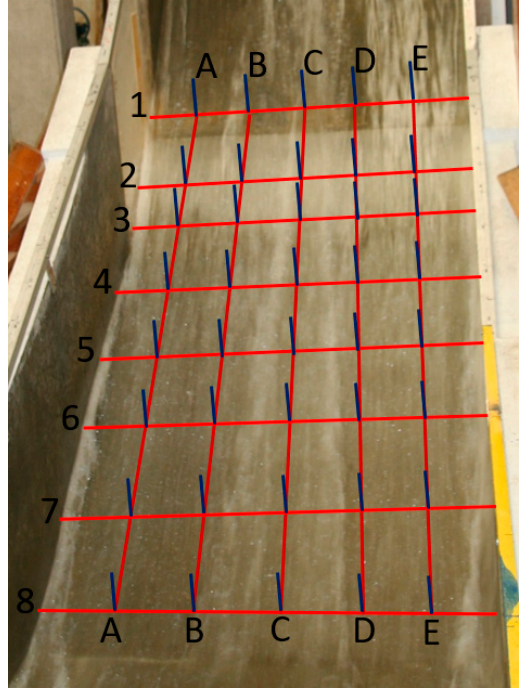
Figure 5. Measuring sections.